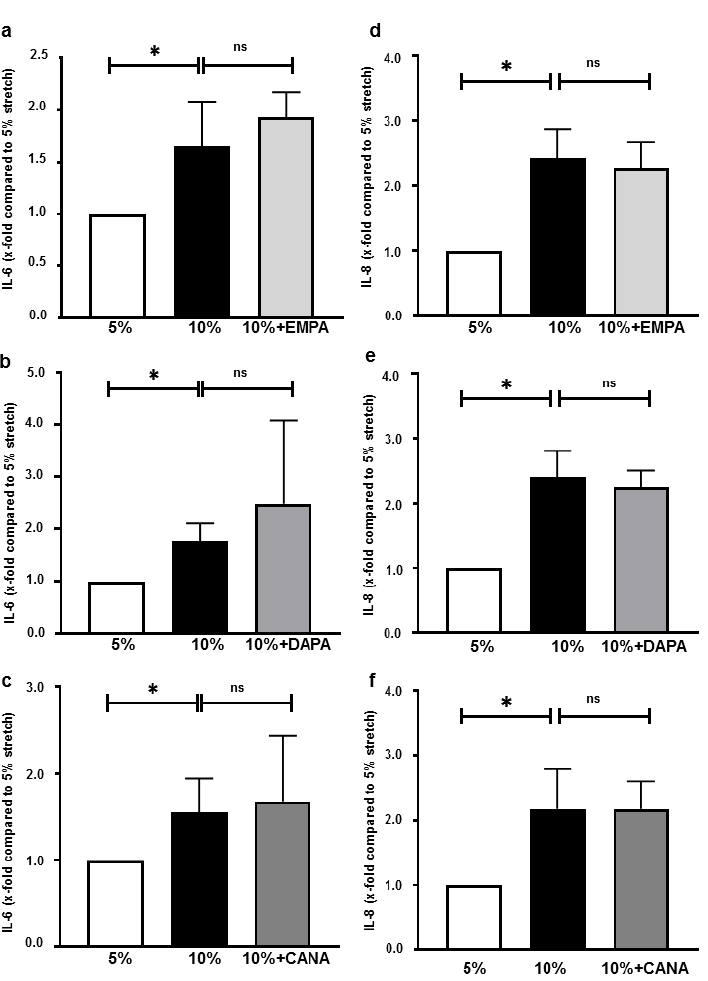
Figure 5. SGLT-2i’s do not inhibit interleukin secretion of endothelial cells exposed to 10% stretch. Cells were pre-incubated for 2 h with vehicle or one of SGLT-2i’s (1 µM EMPA, 1 µM DAPA and 3 µM CANA), and were subsequently exposed to 5% stretch plus vehicle, 10% stretch with vehicle or SGLT-2i’s for 24 h. IL-6 and IL-8 were measured by ELISA ( a – f ) n = 6. Data are presented as mean ± SD. * p < 0.05 vs. 10% stretch. ns: not